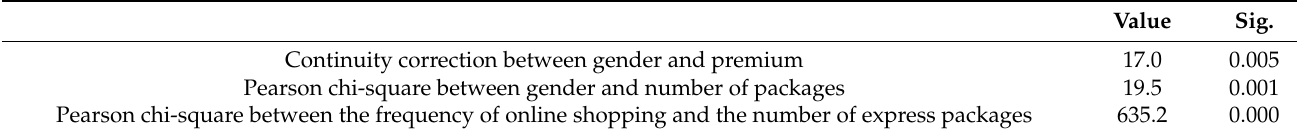
Table 8. Table of chi-square test results on urban. Table 9. Table of chi-square test results on gender and other